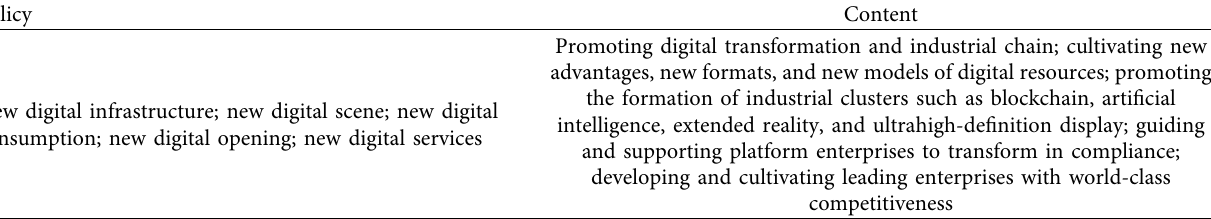
Table 1: Beijing’s “Five New